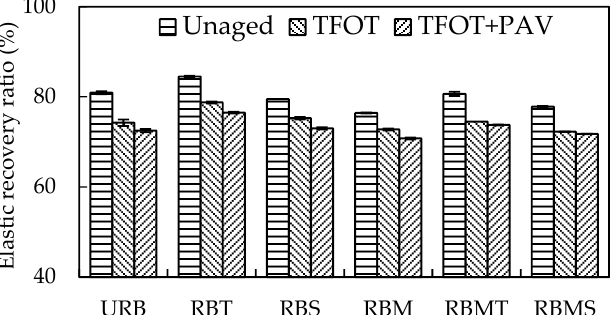
Figure 5. E ff ect of modification methods on the elastic recovery ratio of rubberized Figure 5. Effect of modification methods on the elastic recovery ratio of rubberized bitumen.